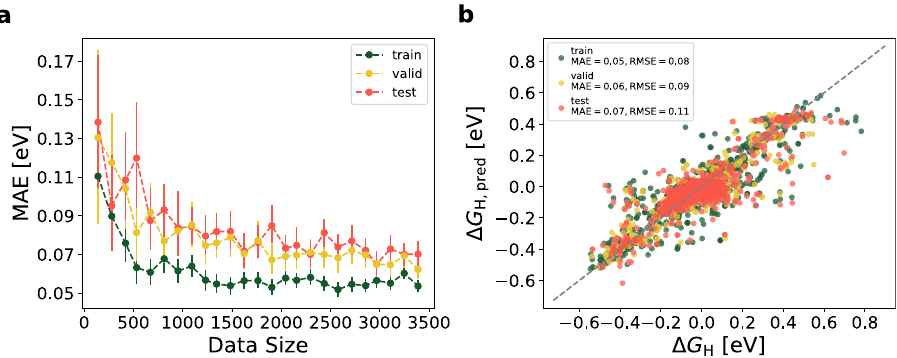
Fig. 8 Machine-learning prediction. a Learning curve of the neural network. The errors are averaged over 25 randomized runs and the error bars indicate the 95% con fi dence interval; b parity plots between predicted and DFT-calculated Δ G H values.